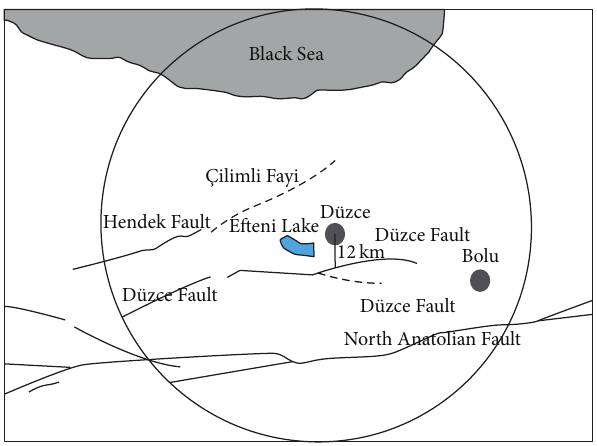
Figure 6: Identification of seismic sources within 100km radius of the study